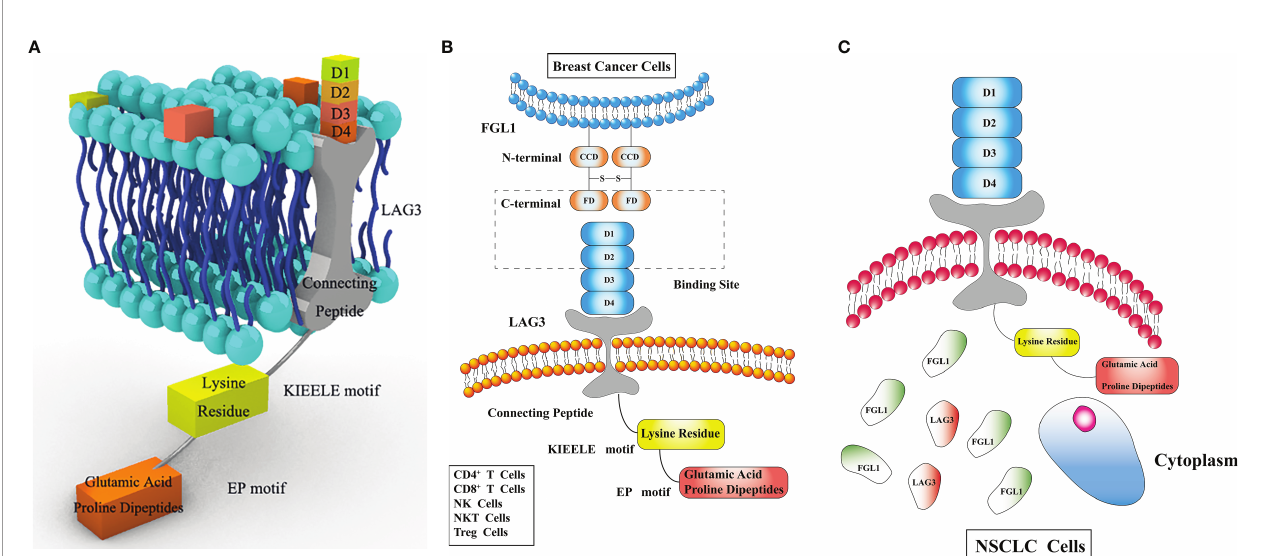
FIGURE 1 | (A) Lymphocyte-activation gene 3 (LAG3) consists of three regions. The extracellular region consists of four immunoglobulin superfamily (IgSF) domains, D1, D2, D3, D4. The transmembrane region consists of a long connecting peptide connected with D4. The intracellular region includes a serine phosphorylation site, a “ KIEELE ” motif and an “ EP ” motif. The “ KIEELE ” motif consists of a lysine residue, and glutamic acid and proline dipeptides constitute the main part of the “ EP ” motif. The “ EP ” and “ KIEELE ” motifs are associated with T cell proliferation and activation. (B) Fibrinogen like 1 (FGL1) consists of an N-terminal signal recognition peptide (coil-coil domain, CCD) and a C-terminal fi brinogen-like domain (FD), without any membrane-crossing region. FD in FGL1, and D1 and D2 in LAG3, are the LAG3 and FGL1 interaction sites. LAG3 is expressed on the surface of CD4 + T cells, CD8 + T cells, natural killer (NK) cells, NK T (NKT) cells and regulatory T (Treg) cells. (C) FGL1 is expressed in various tumors. It is found on the surface of breast cancer cells but in the cytoplasm in non-small cell lung cancer (NSCLC) cell